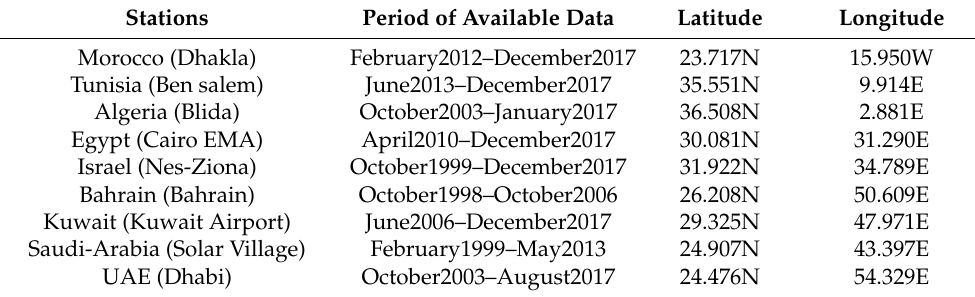
Table 1. The location of the nine selected AERONET stations. Stations Period of Available Data Latitude